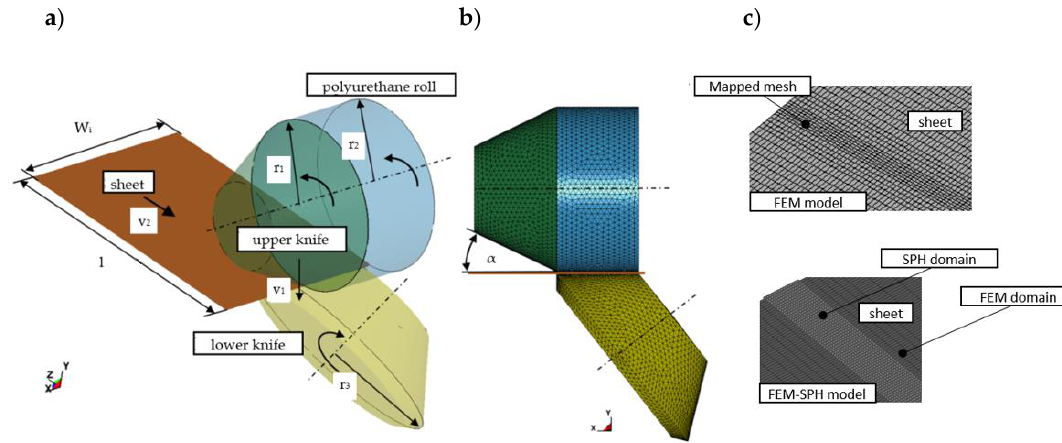
Figure 9. FEM and FEM + SPH simulation models of the shear-slitting process: ( a ) isometric view, ( b ) front view, ( c ) discretization of sheets.